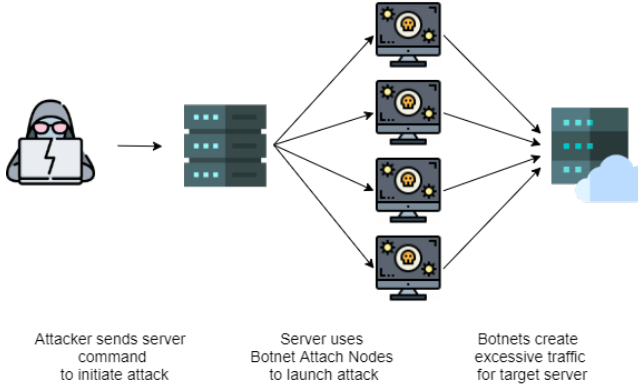
Figure 13. Graphical representation of a botnet attack [99].